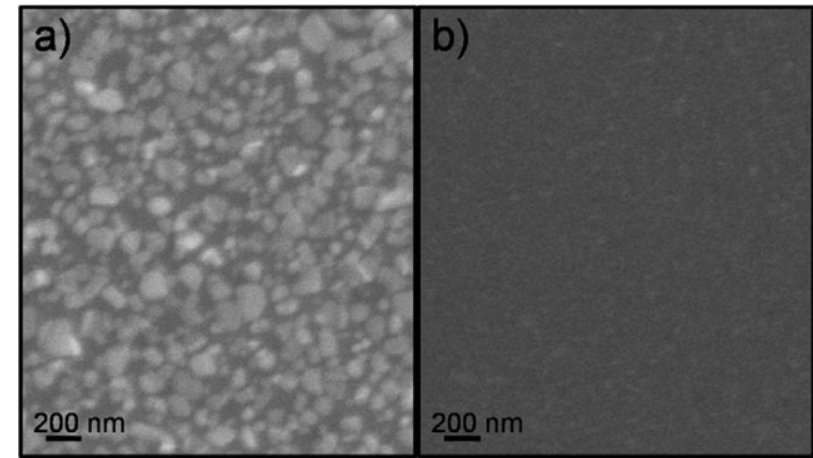
Figure 10. SEM micrographs of thin films: a) 0% PO 43– , 1000 °C and b) 0% PO 43– , 600